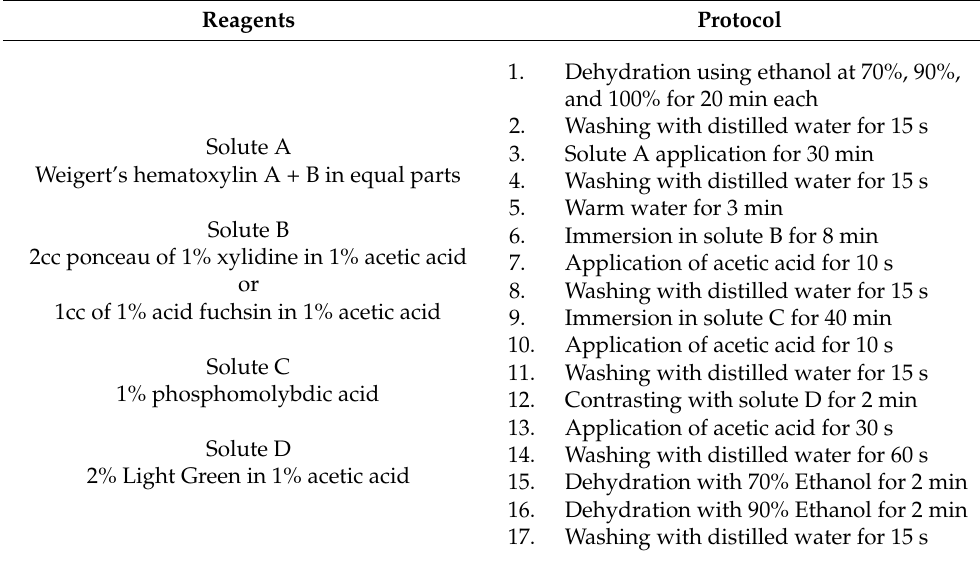
Table 3. Step-by-step procedure of Masson’s trichrome-staining protocol. Thorough washing was carried out before the protocol, in between dehydration solutions and in subsequent steps also to remove visible surface